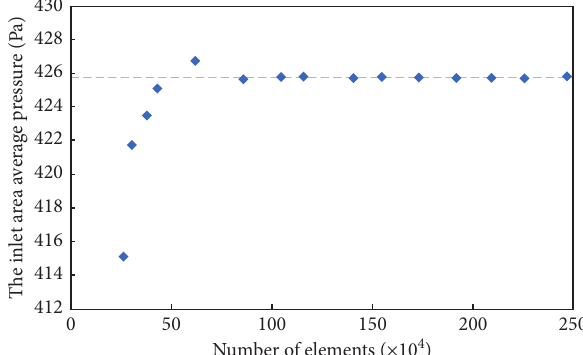
Figure 2: The result of grid independence test and the trend line of the results.